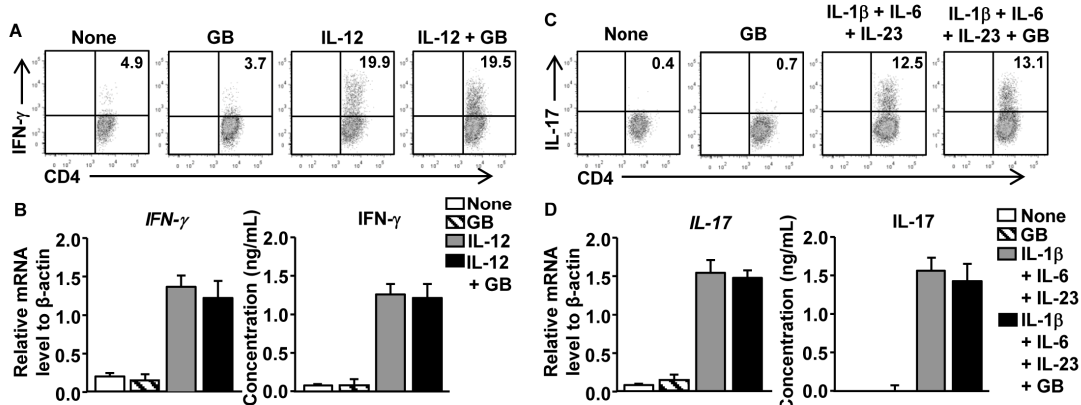
Figure 4. Ginseng berry extract (GB) did not directly inhibit differentiation of Th1 and Th17 cells from naïve CD4 T cells. Purified naïve-enriched CD4 T cells were stimulated with plate-bound anti-CD3 plus anti-CD28 with the indicated cytokines in the presence or absence of GB for 72 h. ( A ) Flow cytometry of IFN- γ expression in CD4 T cells is shown; ( B ) The mRNA levels (left panel) and protein levels of IFN- γ (right panel) are shown; ( C ) Flow cytometry of IL-17 expression in CD4 T cells is shown; ( D ) The mRNA levels (left panel) and protein levels of IL-17 (right panel) are shown. All data are representative of/or the average of analyses of three independent experiments (total n = 6).